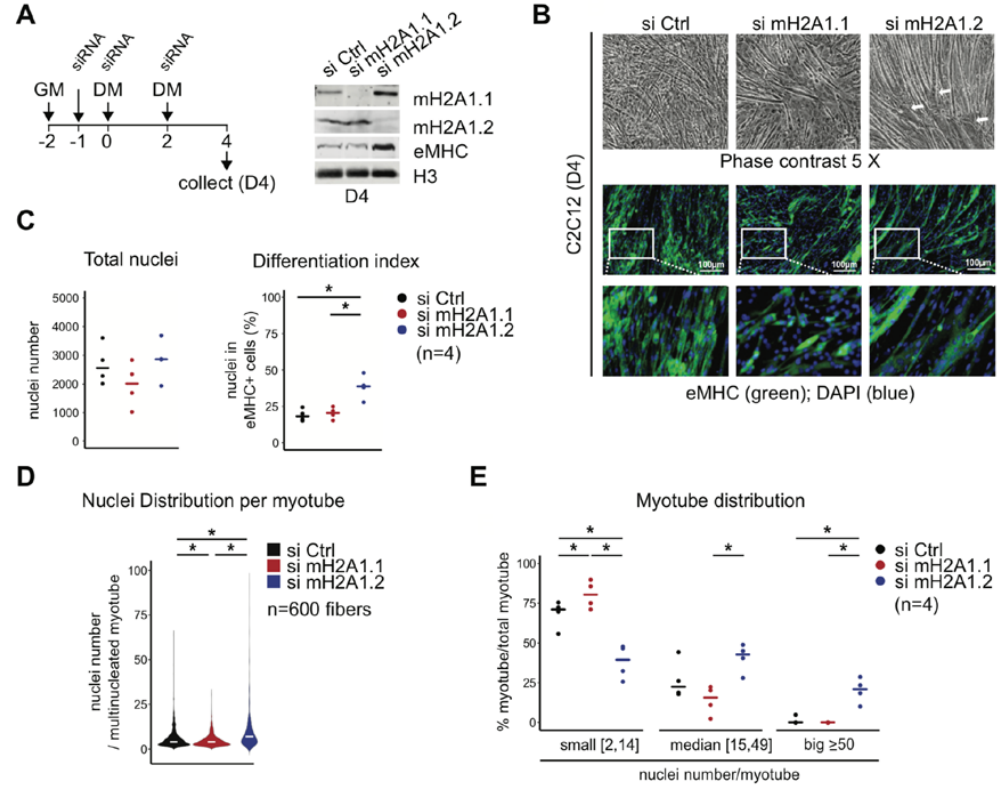
Figure 2. MacroH2A1 isoforms oppositely regulate myotube fusion. ( A ) A schematic representation of the used RNA interference protocol, and the resulting protein levels in C2C12 cells are shown. Immunoblotting was performed by using indicated antibodies. Di ff erentiation was induced by changing growth medium (GM) to di ff erentiation medium (DM), and samples were collected after four days (D4). ( B ) Di ff erences in C2C12 myotube morphology are visible in phase contrast and by anti-eMHC immunofluorescence at D4. Nuclear DNA was counter-stained by DAPI. White arrows indicate particularly large myotubes. ( C ) The total nuclei number and the percentage of di ff erentiated eMHC-positive cells were assessed at D4. Same areas with 600 myotubes were analyzed; data points are from four areas obtained from two independent biological replicates, * p < 0.05; Student’s t -test). ( D ) Violin graph of the nuclei distribution per myotubes. Data in D are the median of 600 myotubes from two biological replicates, * p < 0.05, Wilcoxon test. ( E ) Percent of myotube distribution between three groups: myotubes containing between 2 and 14, between 15 and 49, and more than 50 nuclei. Data points are the median of 600 myotubes, from four areas obtained from two independent biological replicates, * p < 0.05, Student’s t